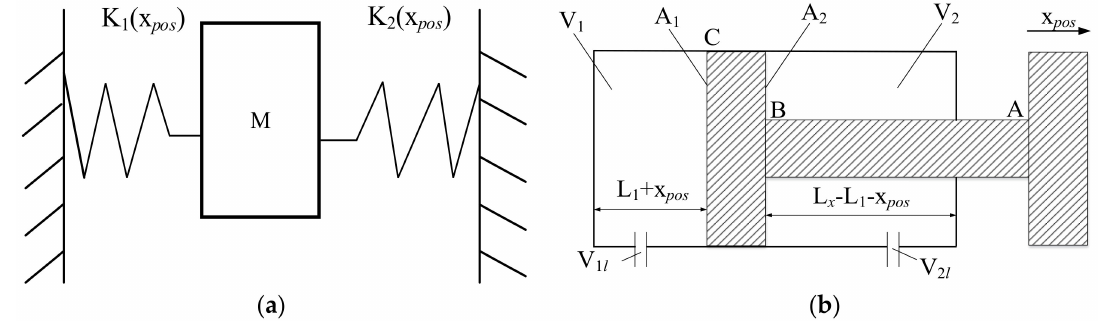
Figure A1. Sti ff ness model of hydraulic cylinder. ( a ) Sti ff ness model of hydraulic oil; ( b ) model of hydraulic